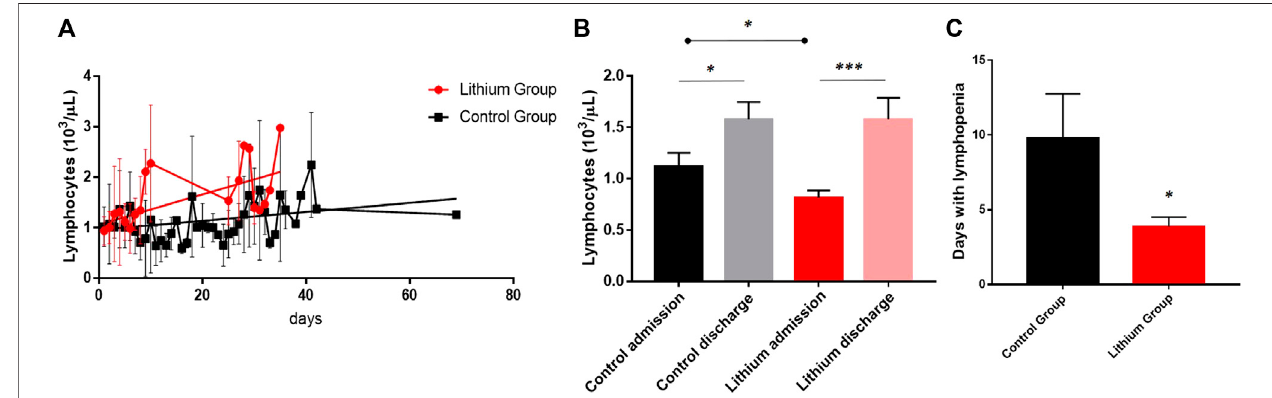
FIGURE 2 | COVID-19 is characterized by very strong lymphopenia, and lithium is a modulator of the immune system. (A) In this graph we represent the mean valuesoflymphocytesinthetwogroupsoftheclinicaltrial,inredthosetreatedwithlithiumandinblackthecontrolgroup.Thelithiumgrouprecoverednormallymphocyte levelsearlier thanthe controlgroup. Thelines show linerregression analysis,where aclear different pattern amonggroups isobserved ( p < 0.05) withdifferentslopesfor lithium group (red line, R 2 = 0.3379) and control group (black line, R 2 = 0.1711). (B) Although both groups recover from lymphopenia, the lithium group recovers signi fi cantly sooner by staying fewer days in lymphopenia. (C) The lithium treatment group remained signi fi cantly less days in lymphopenia than the control group ( p <